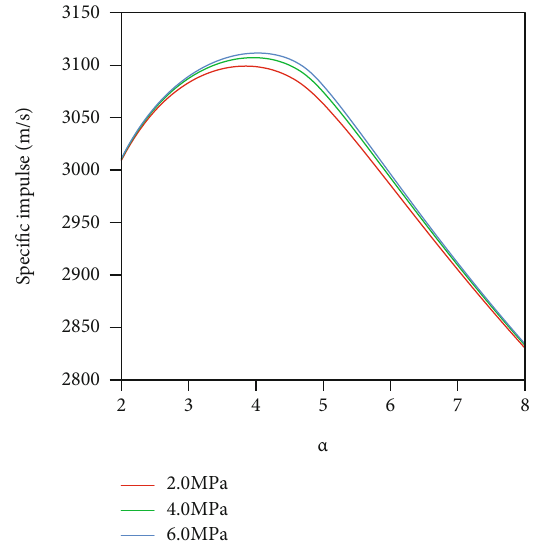
α curves under di ff erent chamber Figure 5: I s -